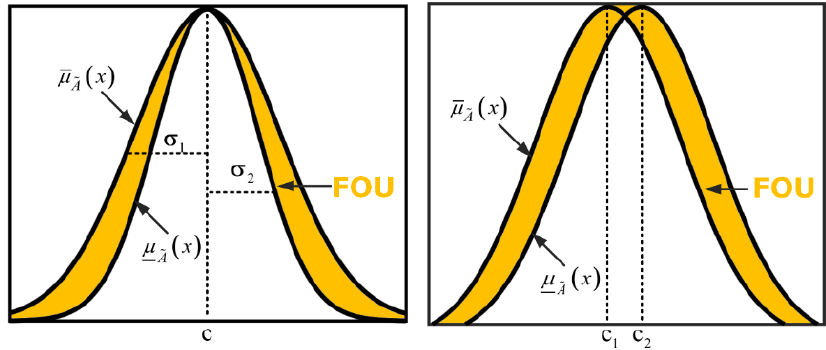
Figure 3. Gaussian Type-2 fuzzy set.